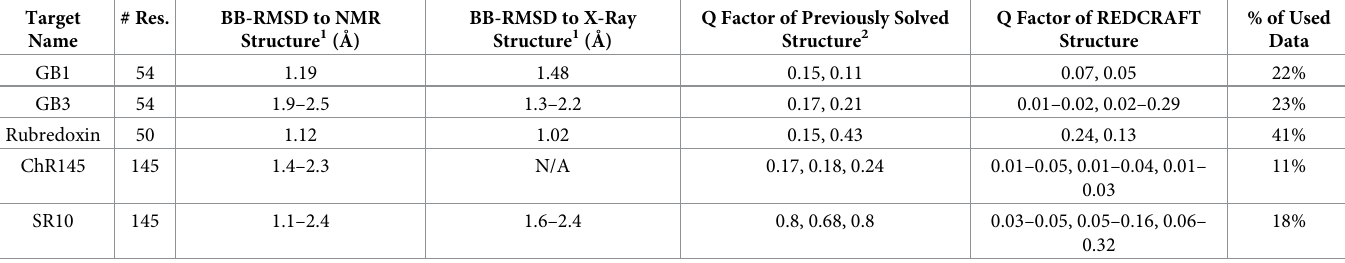
Table 1. Results for REDCRAFT’s structure calculation using experimental